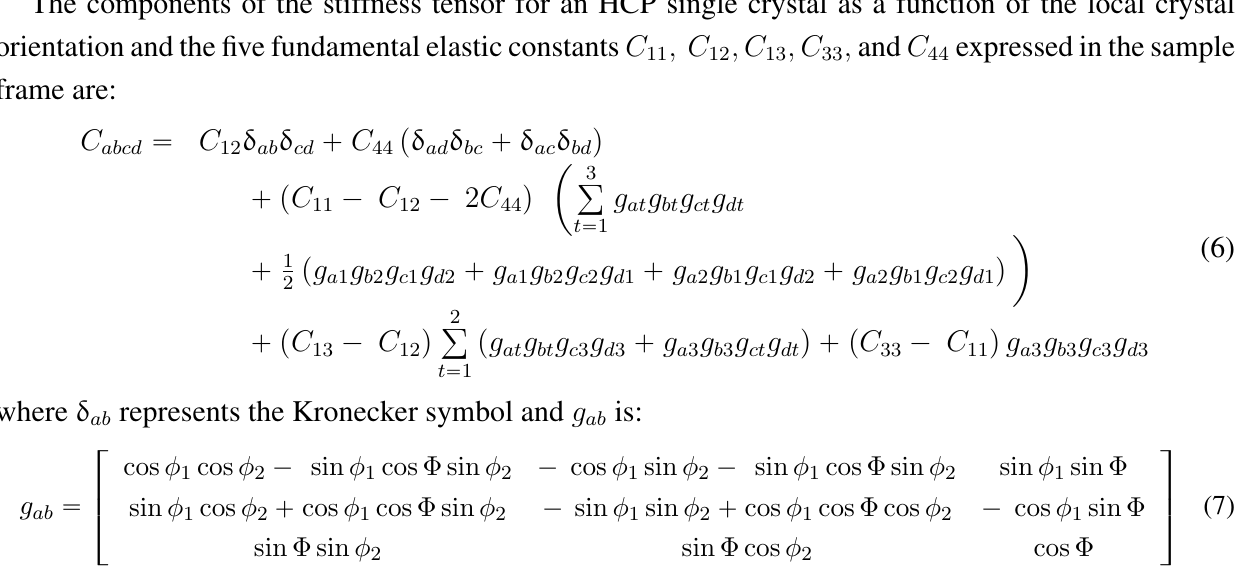
Figure 1. Examples of the fast Fourier transforms (FFT) texture hull for HCP-triclinic materials. Two arbitrarily selected normalized projections are: ( a ) ReF 004 , ImF 004 , ImF 041 and ( b ) ReF 444 , F 200 , ImF 444 .